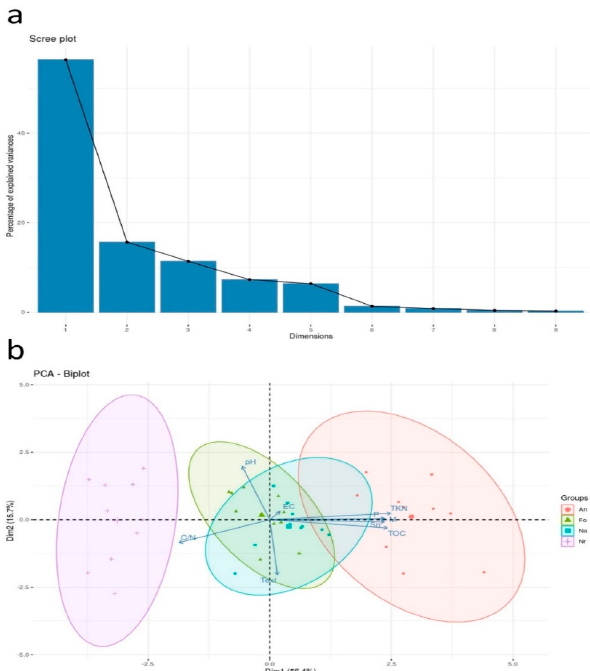
Figure 5. ( a ) Percentage of variances explained by each principal component; ( b ) PCA biplot of samples and variables, obtained from the analyzed variables for the different soil types. P, available phosphorus; TKN, total Kjeldahl nitrogen; TOC, total organic carbon; M, relative mycorrhization intensity; Sn, spore number; EC, electrical conductivity.